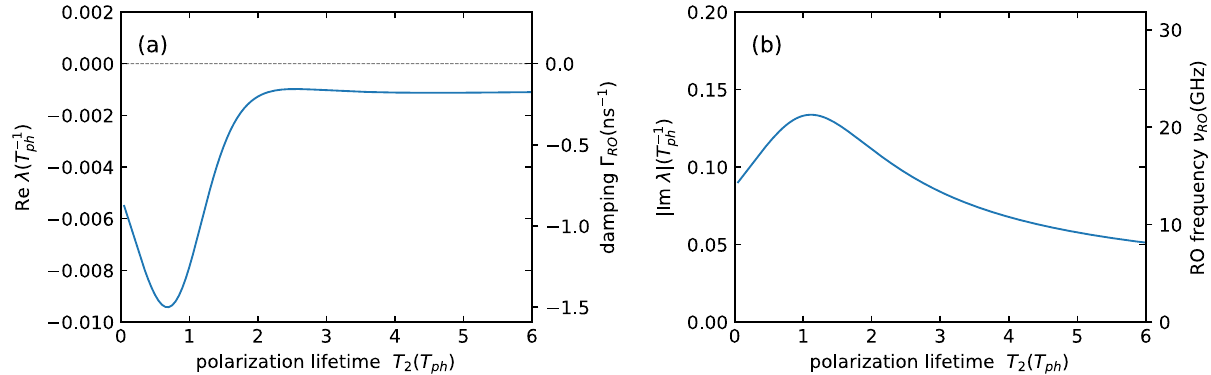
Figure 2. Complex eigenvalue of the linearized Class-C equations for a solitary laser. ( a ) Real part eigenvalue describing the relaxation-oscillation (RO) damping, ( b ) Absolute value of the imaginary part yielding the RO frequency as a function of the polarization lifetime T 2 . The secondary y-axes show a conversion to physical units assuming a photon lifetime of T ph = 1ps . Other parameters are �ω = 3 , p = 2 , K = 0 and T = 392